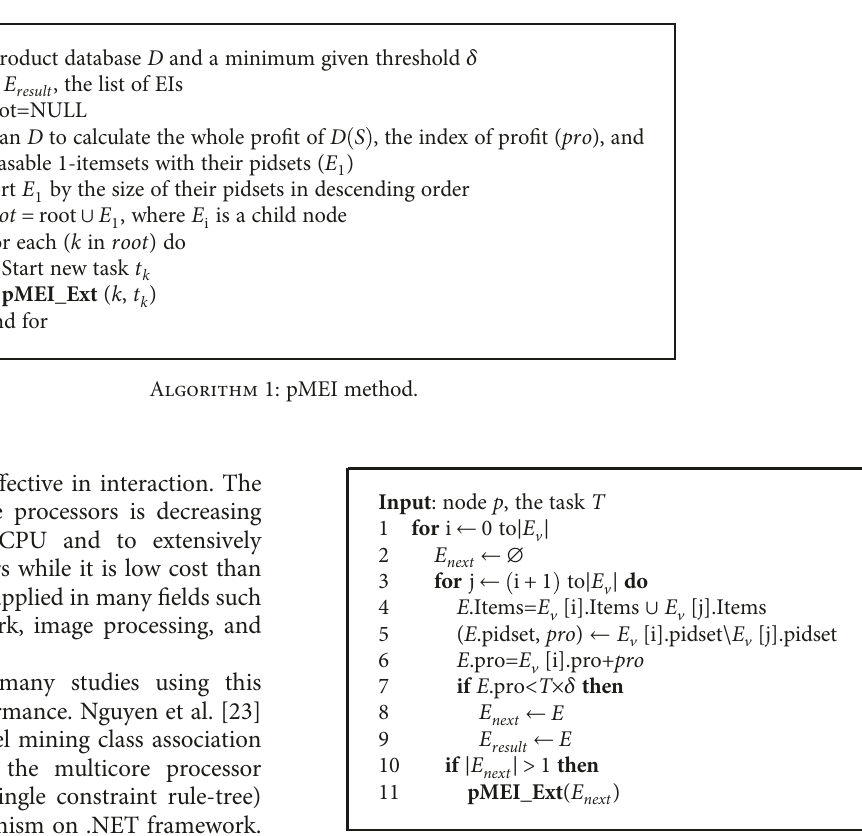
Algorithm 2: Procedure